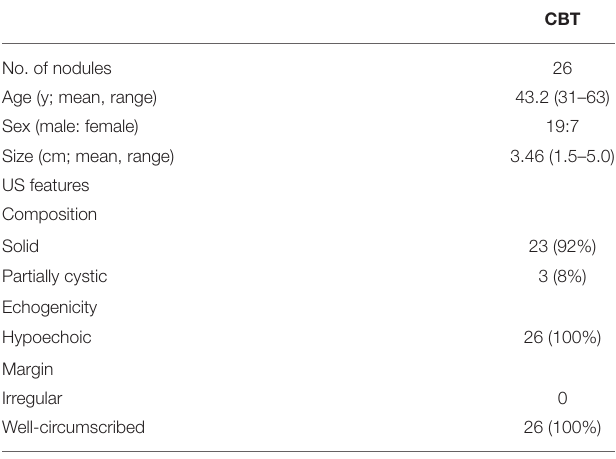
TABLE 1 | Clinical and US characteristics of CBT lesions.